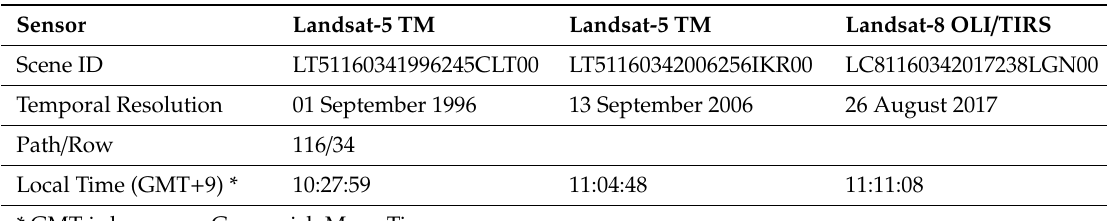
Table 1. Landsat Level 2 data